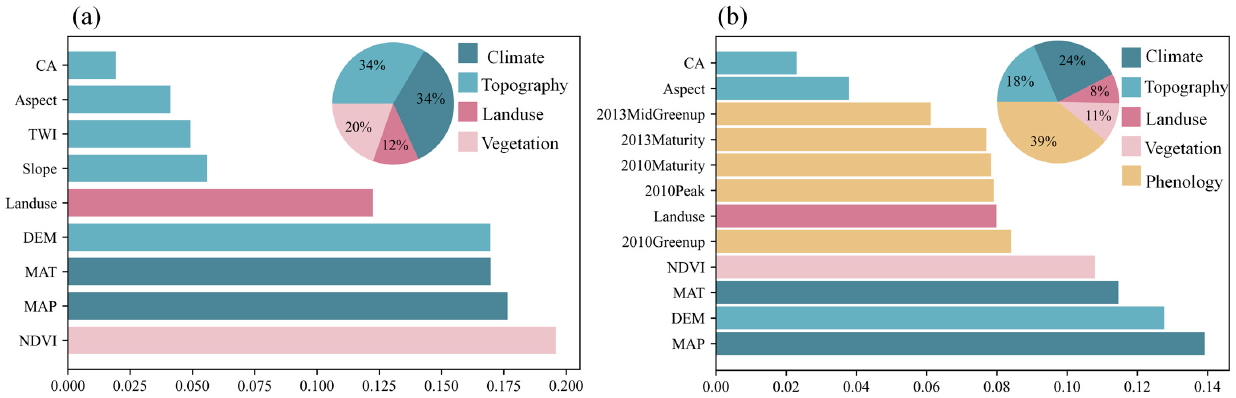
Figure 7. The spatial distribution of SOC content predicted by RF using commonly used variables ( a ) and commonly-used variables and phenological variables ( b ).